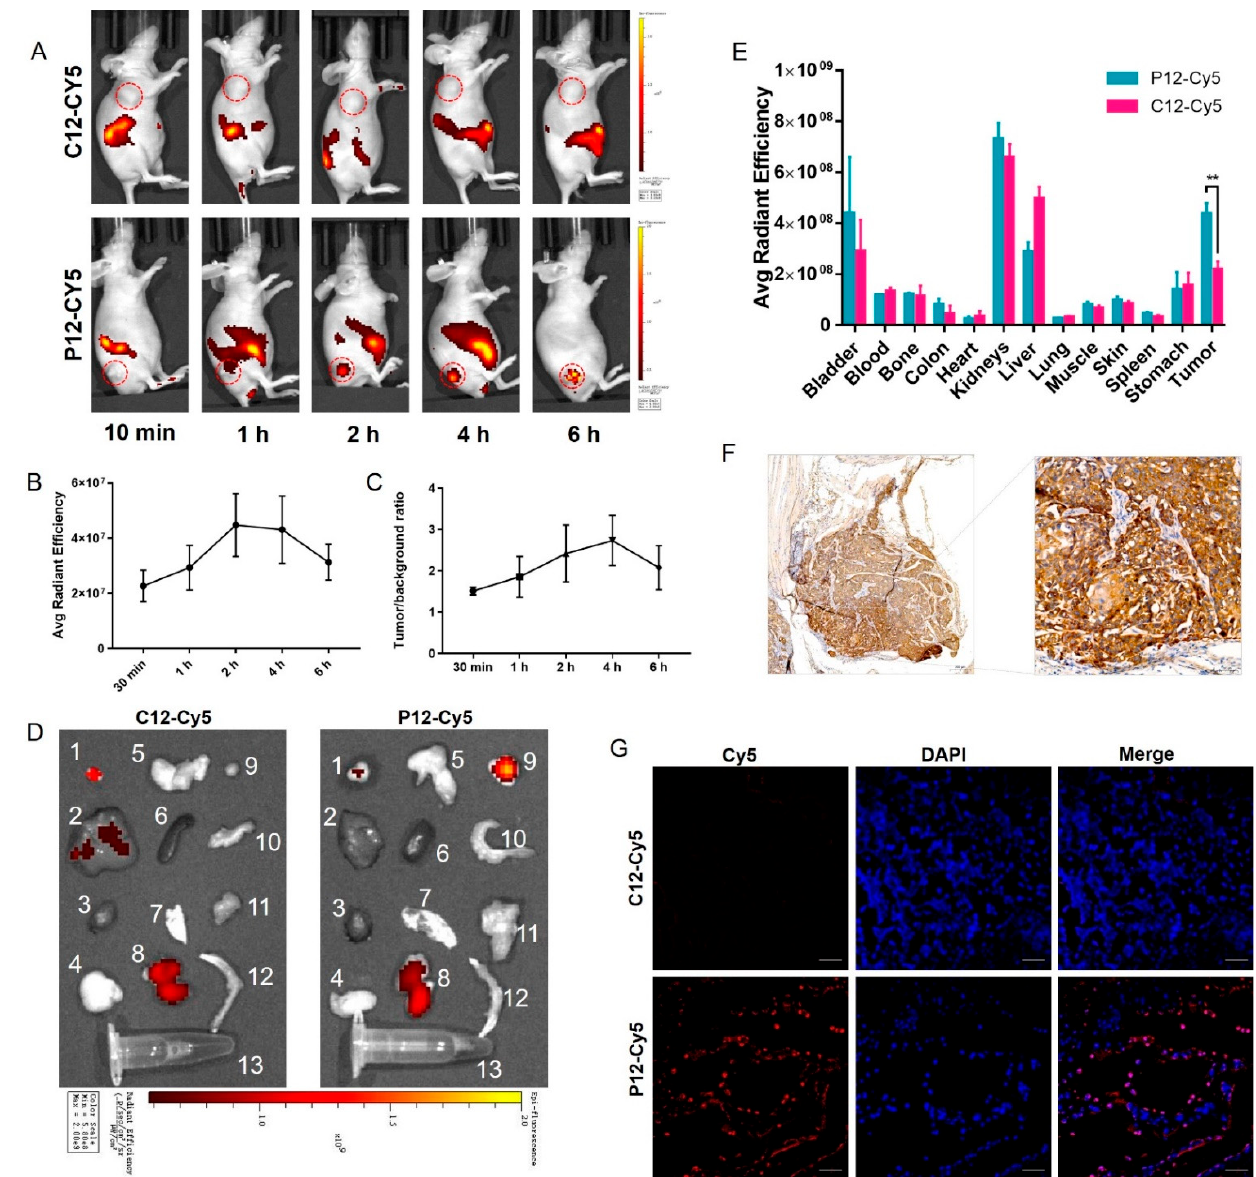
Figure 5. NIRF imaging in KYSE-30 bearing xenograft models. ( A ) Representative NIRF images of KYSE-30 tumor-bearing mice (n = 3) postinjection with P12-Cy5 and C12-Cy5 at different time points. ( B , C ) The MFI and TBR quantified from ROI in P12-Cy5 administrated mice (n = 3). ( D ) NIRF images of resected tumors and main organs 2 h postinjection of P12-Cy5 and C12-Cy5 (n = 3). Serial numbers indicate different organs and tissues. 1: bladder, 2: liver, 3: heart, 4: lung, 5: stomach, 6: spleen, 7: skin, 8: kidneys, 9: tumor, 10: colon, 11: muscle, 12: bone, 13: blood. ( E ) Quantitative biodistribution of P12-Cy5 and C12-Cy5 quantified from resected tumors and main organs (n = 3). ( F ) Representative images of IHC staining in tumors resected after imaging. Magnification, left 50×, right 200×. ( G ) Immunofluorescence images of the frozen section from KYSE-30 tumor tissues after imaging. Scale bar: 100 μ m.